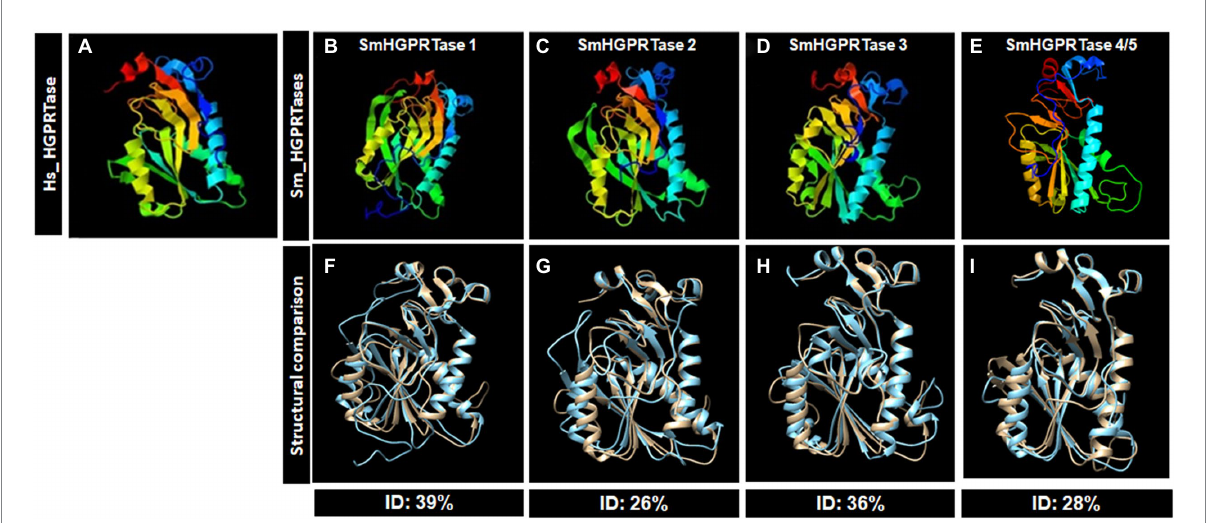
FIGURE 2 Predicted tridimensional structures for HGPRTases from Schistosoma mansoni and their human ortholog. Using the Phyre2 web portal the HGPRTase proteins from human (A) and S. mansoni (SmHGPRTase 1 – B , SmHGPRTase 2 – C , SmHGPRTase 3 – D , and SmHGPRTase 4/5 – E ) were modeled and overlapped. Secondary structure elements are rainbow-colored from blue at the N-terminus to red at the C-terminus (A–E) . The percentage identities were calculated using the predicted models and the overlaps between the respective structures are represented below (F–I) . In gray, human protein; In blue, Schistosoma